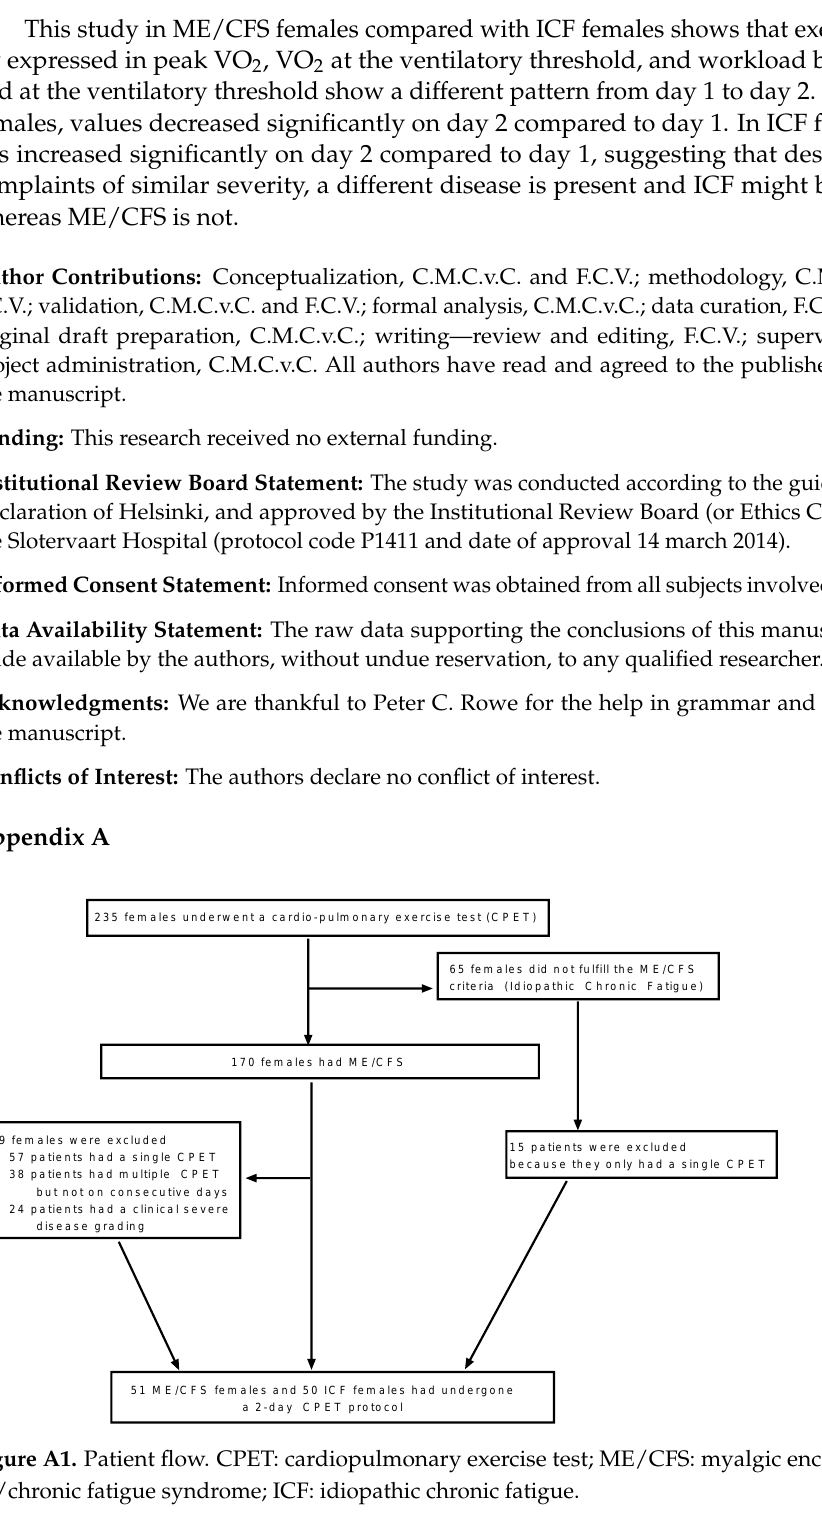
Figure A1. Patient flow. CPET: cardiopulmonary exercise test; ME/CFS: myalgic encephalomyelitis/chronic fatigue syn- drome; ICF: idiopathic chronic fatigue.